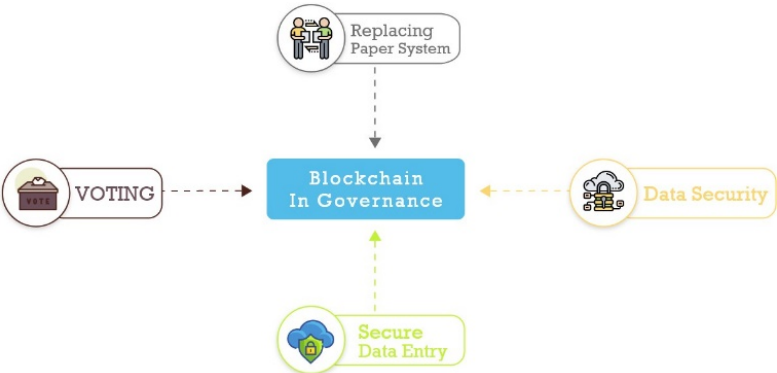
Figure 12. Blockchain in governance.